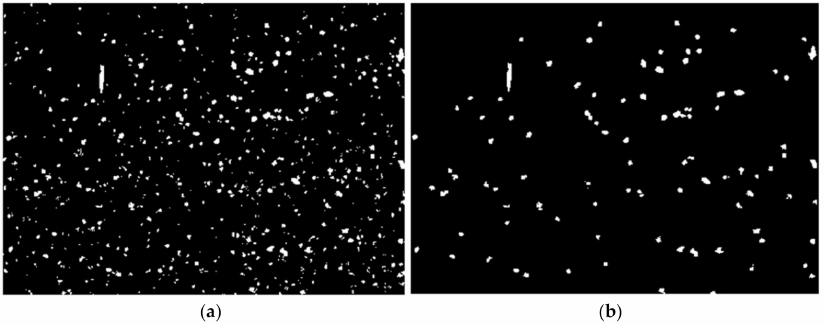
Figure 10. Filtering fibers with circular and elliptical cross-sections. ( a ) before, ( b ) after filtering.